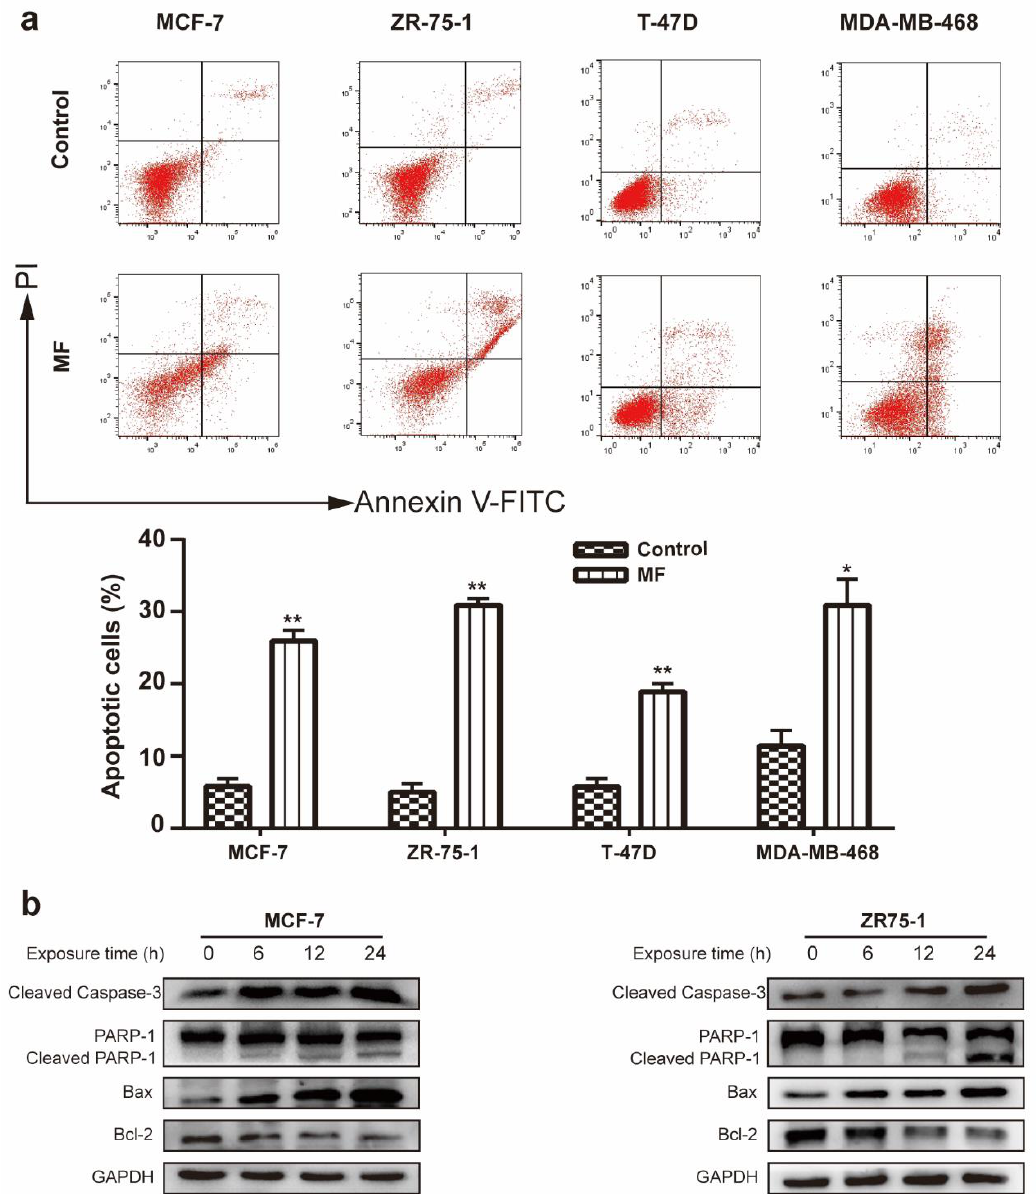
Figure 2. Effects of MF on breast cancer cell apoptosis. ( a ) Flow cytometry images (up) showing the expression levels of Annexin V- and PI-labeled MCF-7, ZR-75-1, T47D, and MDA-MB-468 cells following a 24 h-treatment with or without MF (200 Hz, 1 mT). Histograms (down) illustrating the number and distribution of apoptotic cells in the total cell population. ( b ) Western blotting analysis of the expression levels of cleaved caspase-3, PARP1, Bax, and Bcl-2 in both MCF-7 and ZR-75-1 cells following exposure to MF for each designated time. In addition, GAPDH was used as a reliable internal control. Data are presented as the mean ± standard deviation (SD); n = 3; * p < 0.05, ** p < 0.01.